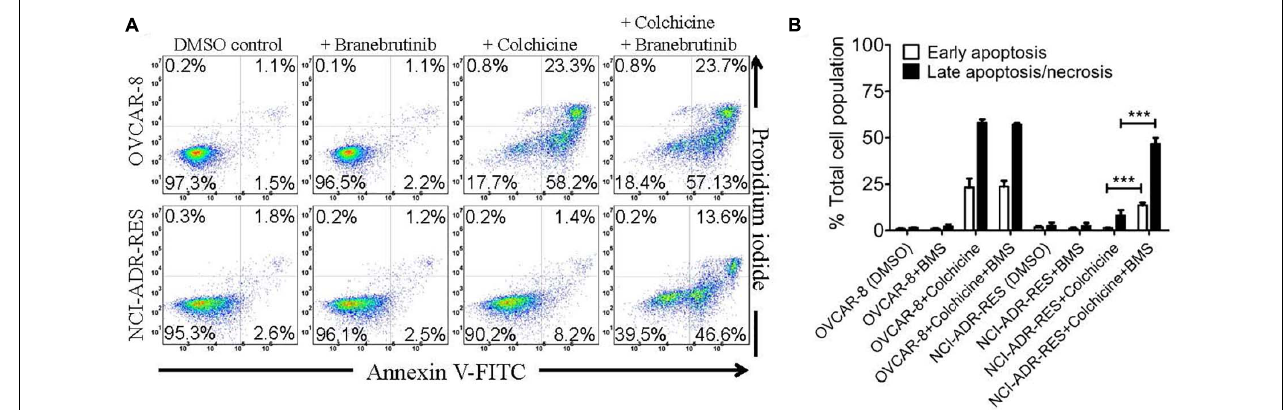
FIGURE 4 | Branebrutinib enhances colchicine-induced apoptosis in P-glycoprotein (P-gp)-overexpressing cancer cells. Drug-sensitive OVCAR-8 and the P-gp-overexpressing multidrug-resistant NCI-ADR-RES cancer cells were treated with DMSO (control), branebrutinib at 20 µ M (+BMS), colchicine at 500 nM (+ colchicine), or a combination of colchicine and branebrutinib (+colchicine + BMS) for 48 h, processed and analyzed by flow cytometry as described in Materials and methods. Representative flow cytometric dot plots are shown (A) and the corresponding quantification (B) are presented as mean ± SD. Calculated from at least three independent experiments. *** p < 0.001, versus the same treatment in the absence of branebrutinib.